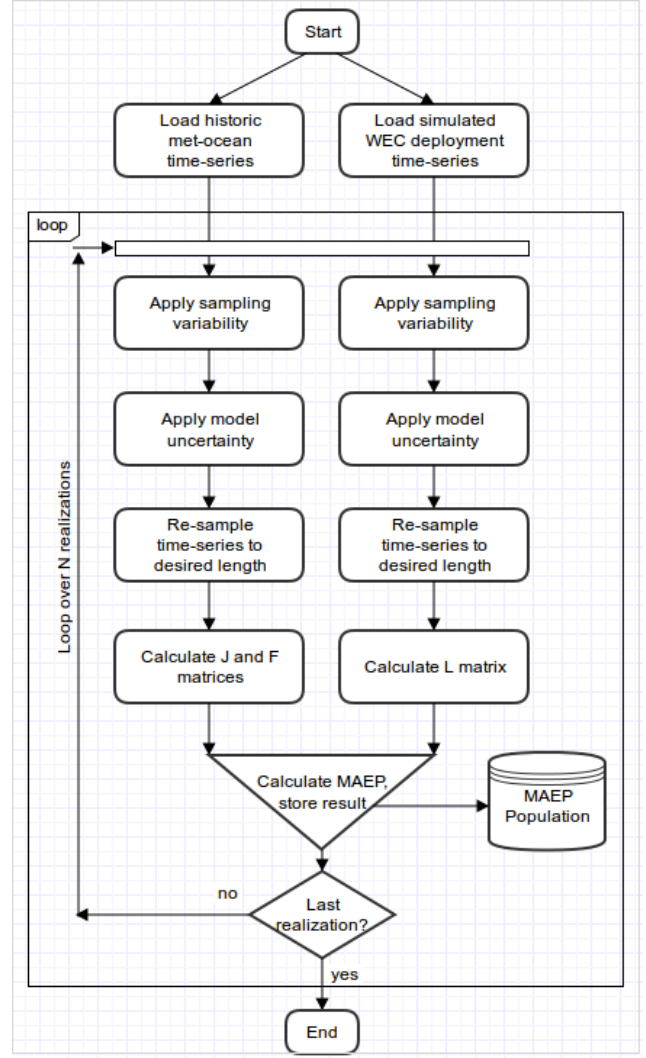
Figure 3. Flow chart of Monte Carlo simulation